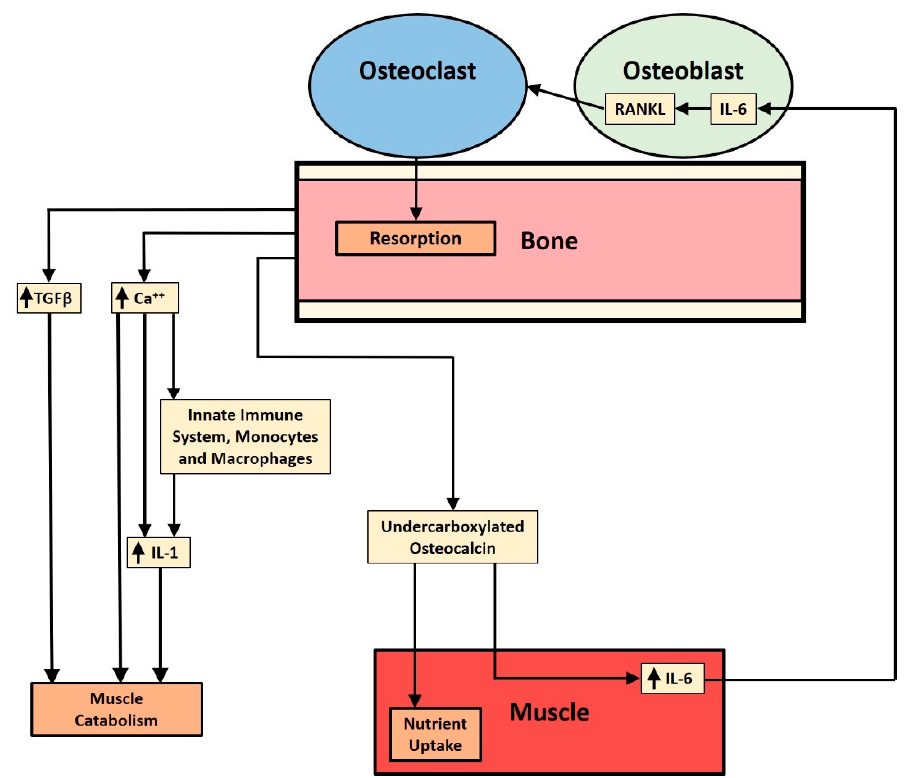
Figure 1. Schematic diagram illustrates the three pathways affecting muscle that are stimulated by bone resorption and mediated by proinflammatory cytokines. From the outside in, there is TGF- β release, ionized calcium release, and undercarboxylated osteocalcin release. The TGF- β and ionized calcium are catabolic, while the osteocalcin pathway has an anabolic component. The purpose of the juxtaposition of the three pathways is to raise the questions of how release is controlled and how the quantities of each substance released are regulated. TGF- β suppresses the anabolic AKT/mTOR pathway in muscle while upregulating the catabolic ubiquitin ligase pathway. Ionized calcium stimulates the NLRP3 inflammasome to produce IL-1 and mononuclear cells to release more chemokines in order to prolong or intensify inflammation and muscle loss. Osteocalcin stimulates muscle to take up more nutrients and to increase production of IL-6, which stimulates osteoblasts to make RANK ligand, stimulating osteoclastogenesis and release of undercarboxylated osteocalcin from bone.